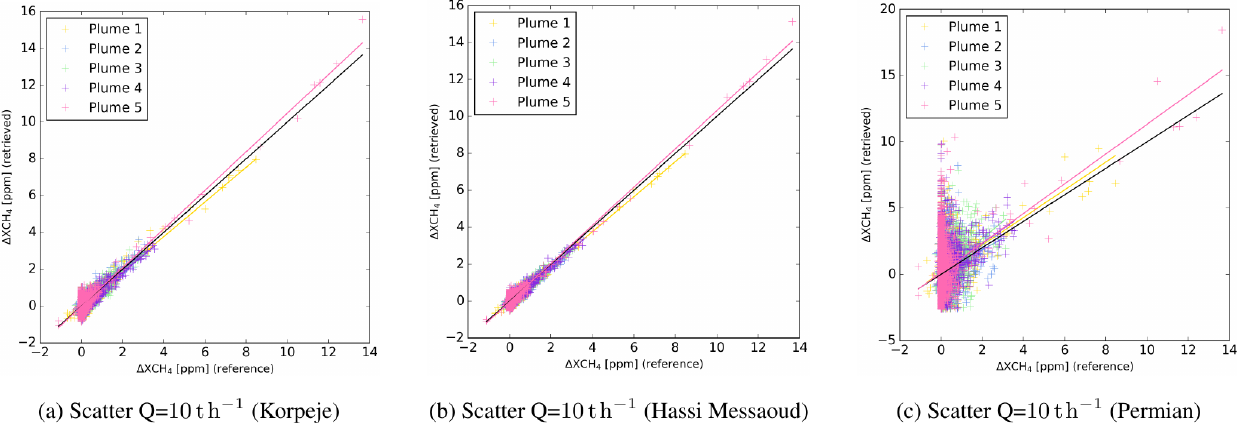
Figure 8. Scatter plots of the retrieval results against the validation reference at a pixel level for Korpeje (a) , Hassi Messaoud (b) and the Permian Basin (c) for a simulation that includes the methane plume 2 (see Fig. 3b) scaled to a flux rate Q = 10000kgh − 1 .